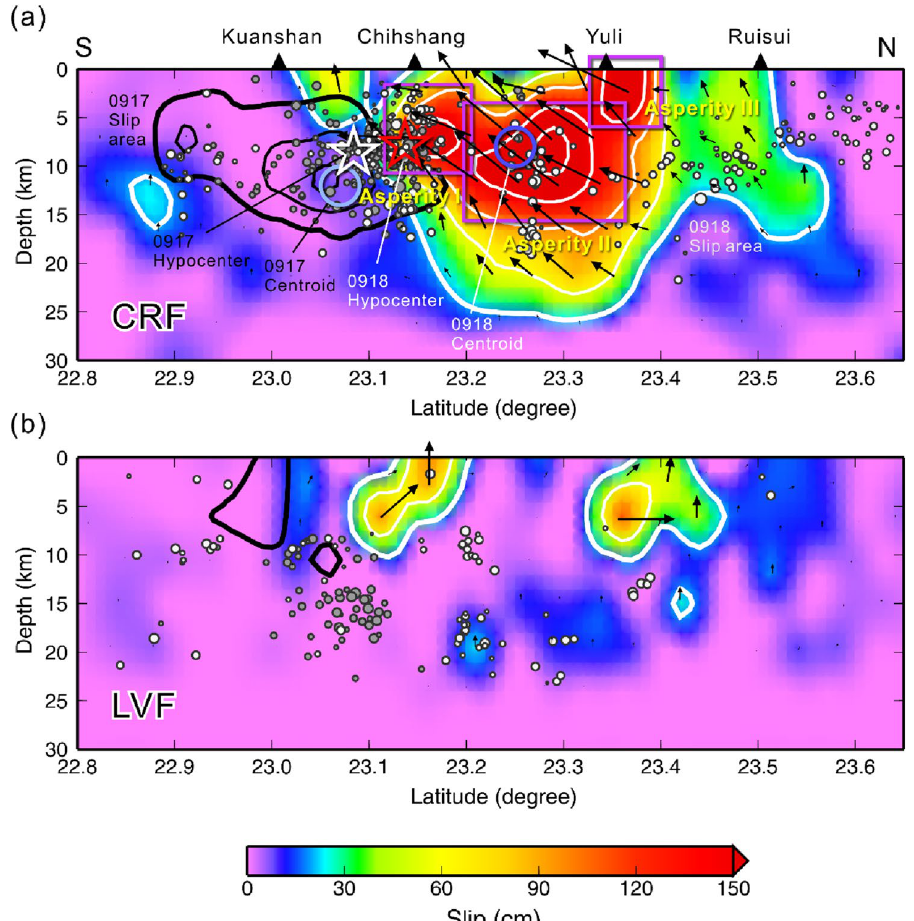
Figure 2. Distribution of slip on the: ( a ) west-dipping Central Range Fault, and ( b ) east-dipping Longitudinal Valley Fault. Red and white open stars are the hypocenters of the mainshock and foreshock, respectively. Dark and light blue open circles are the centroid locations of the mainshock and foreshock determined by the Real-time Moment Tensor monitoring system 4 (https:// rmt. earth. sinica. edu. tw). White contours are the slip distribution of the mainshock, and the black contours show the slip of the foreshock. The minimum threshold for contours is 20 cm, the second and third minimums are 60 and 100 cm respectively, and increments every 50 cm thereafter. Purple rectangulars indicate the three asperities on the fault plane. The events before the 0918 mainshock (from 2022/09/17 to 2022/09/18 06:35) are shown in solid gray circles, and the events after the mainshock (from 2022/09/18 06:44 to 2022/09/30 19:51) are presented with white circles. This aftershocks information is provided by CWB earthquake catalog 37